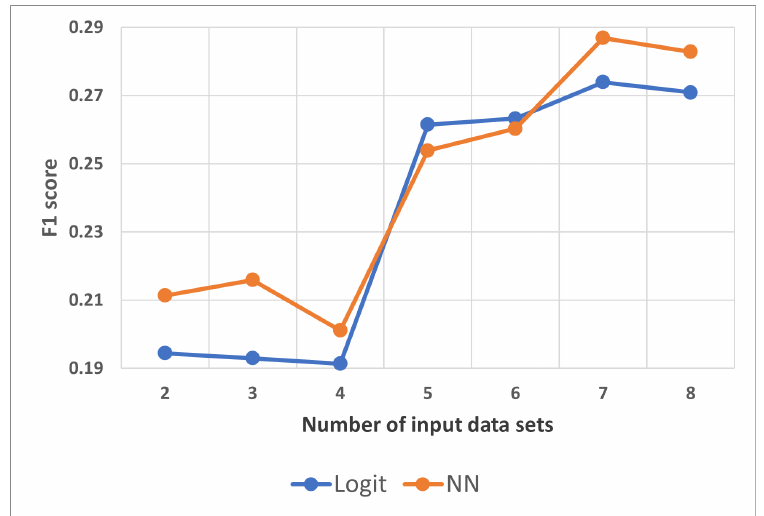
Figure 8. Comparison test F1 score, ANN and logistic regression.